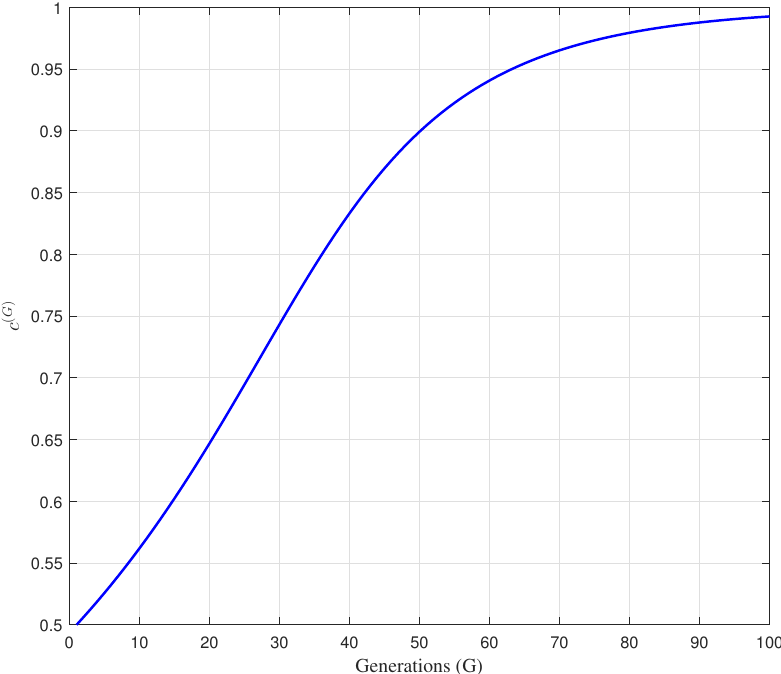
Figure 3. The changes of the adaptive sensory fragrance c ( G ) during the optimization